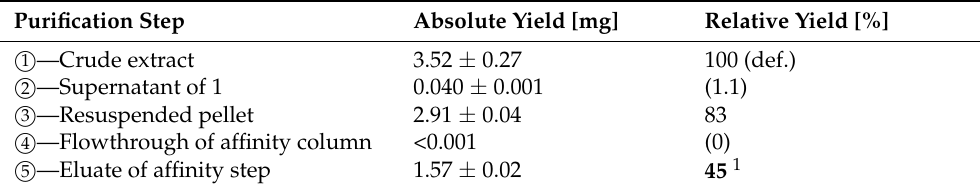
Table 1. The yield of CCMV after each purification step: absolute values in mg; relative values in per cent relative to 100% determined for the crude extract. Errors were taken from quadruplicate absorbances, calculating the concentrations from the calibration function and determining their standard